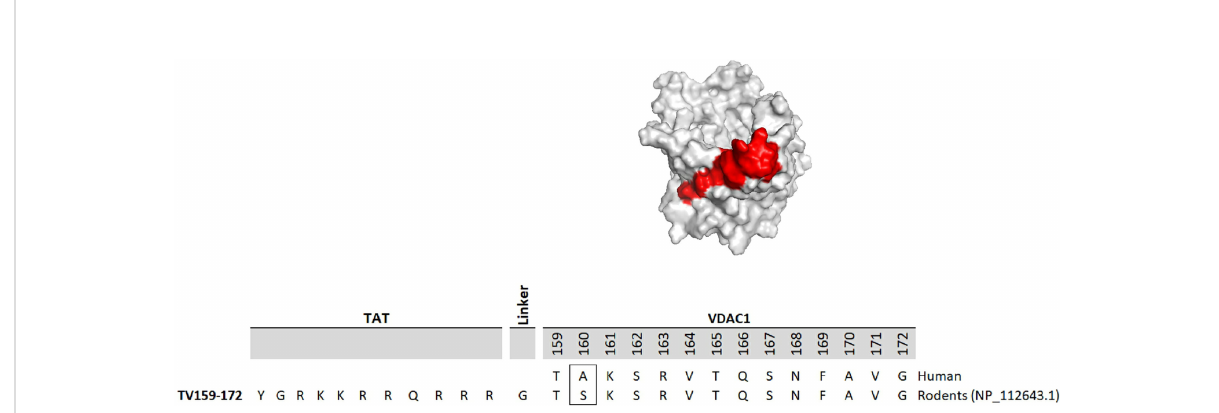
FIGURE 1 TV159-170 is a fusion peptide. The fi gure shows the human VDAC1 structure where the red depicts the VDAC1 amino acids contained in TV159- 170, which are oriented towards the cytosol. The human VDAC1 protein sequence differs from the rodents only at amino acid